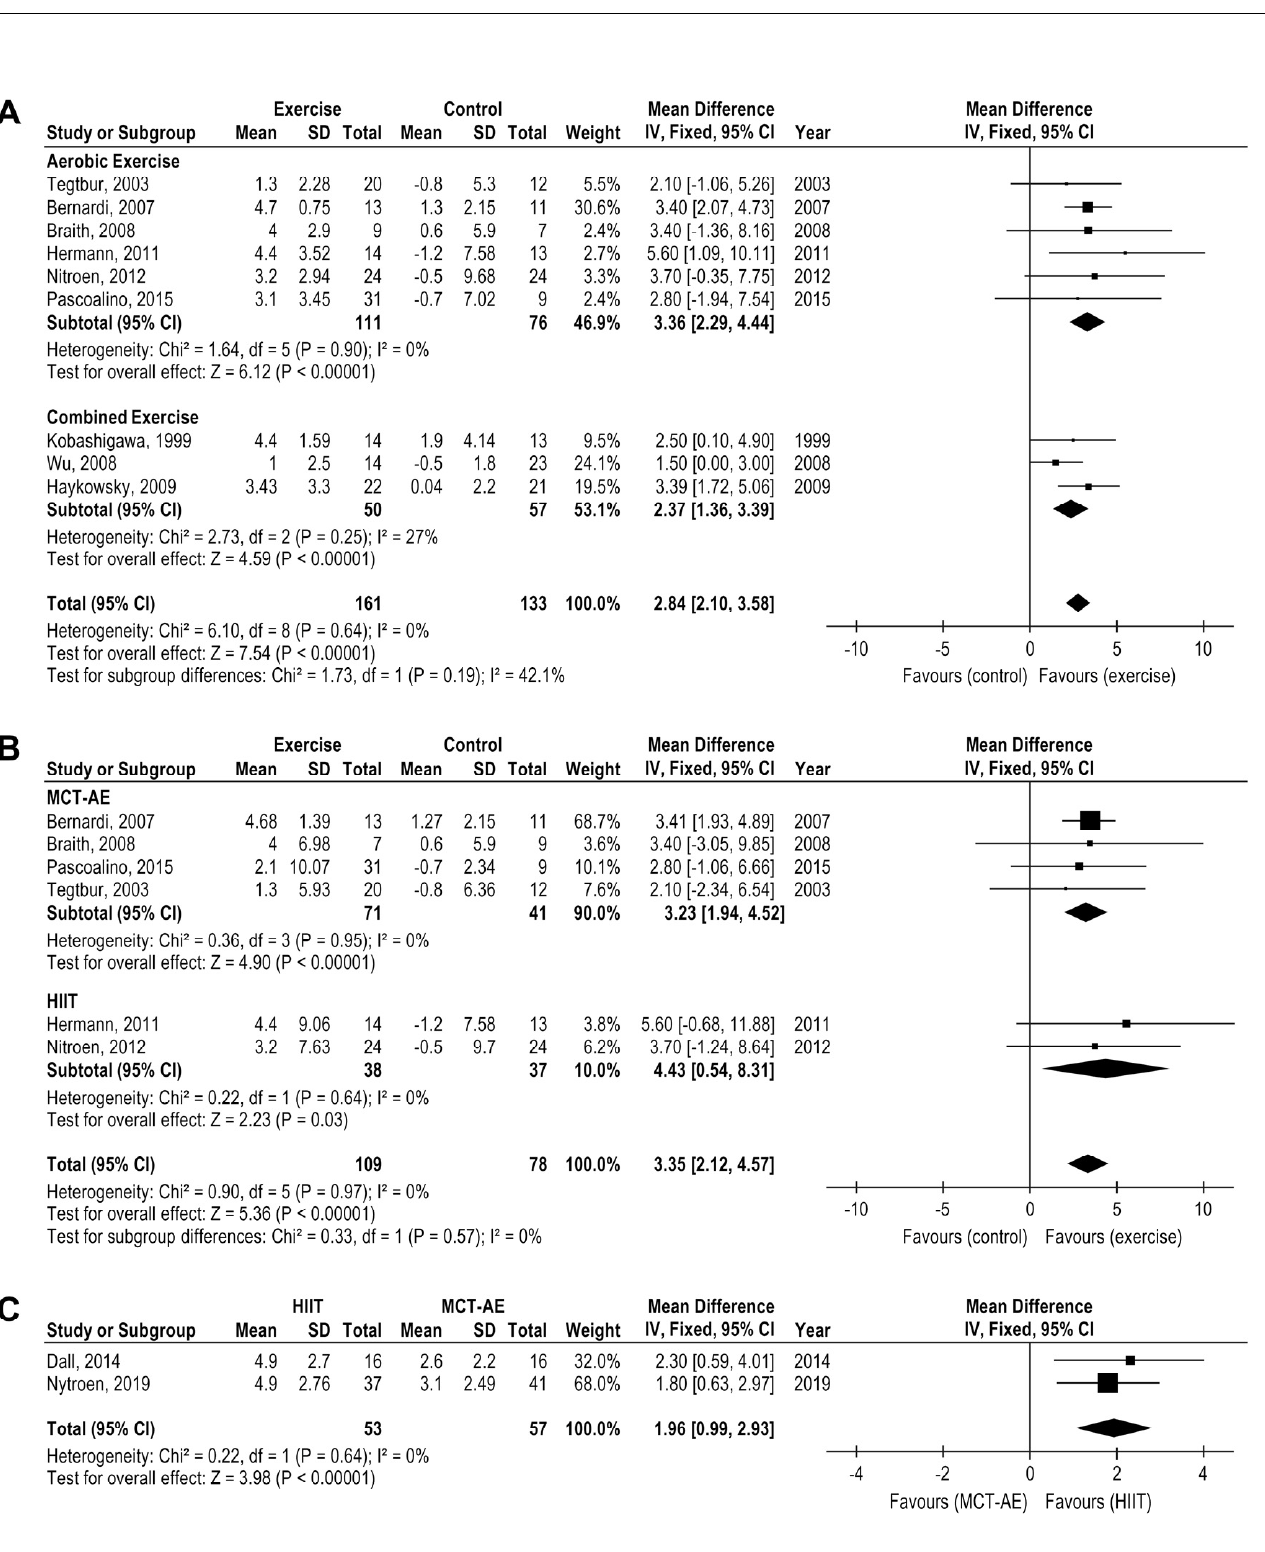
Figure 2. Impact of exercise training on V (cid:48) O 2 peak (mL.kg.min) in HTx ( A ) exercise versus the control group ( B ) moderate continuous training and high-intensity training versus the control group ( C ) moderate continuous training versus high-intensity interval